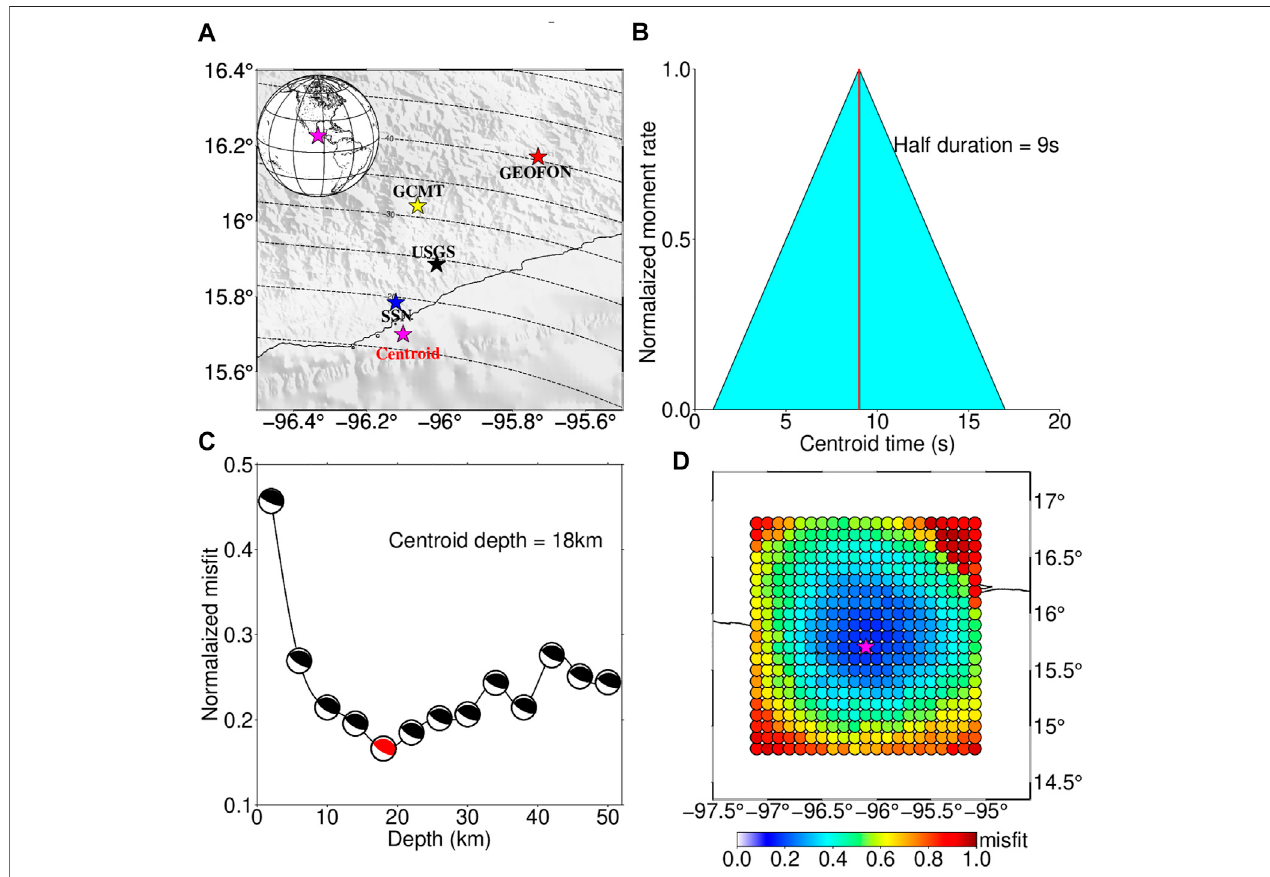
FIGURE 2 | Map of the epicentral region of the 2020 Oaxaca earthquake and centroid moment tensor solution. (A) Map view of the epicentral locations, black, yellow, red, blue, and magenta stars show the epicenters from the USGS, GCMT, GEOFON, SSN, and this study, respectively. (B) Searched normalized moment rate function. (C) Map view of the normalized mis fi t between the observed and synthetic data with different centroid depths; the black beach ball denotes the focal mechanismwiththedepthandtheredbeachballdenotestheoptimal focalmechanismwhenthecentroiddepthisselectedat18 km. (D) Normalizedresidualwith the different centroid epicentral locations used in our study